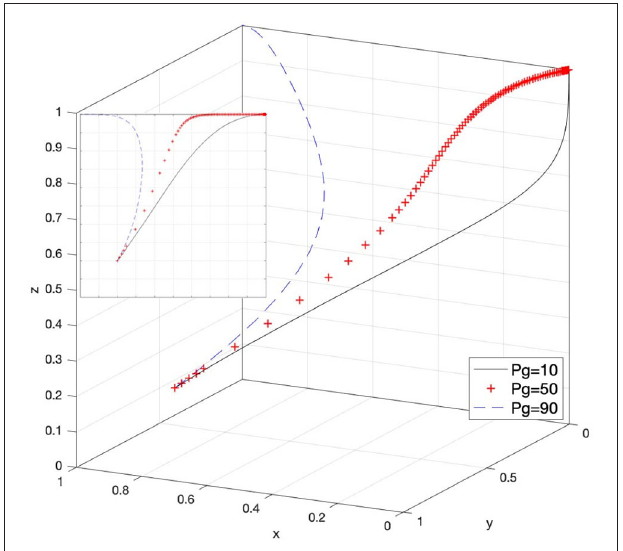
holders actively protect their rights, and the government chooses strict